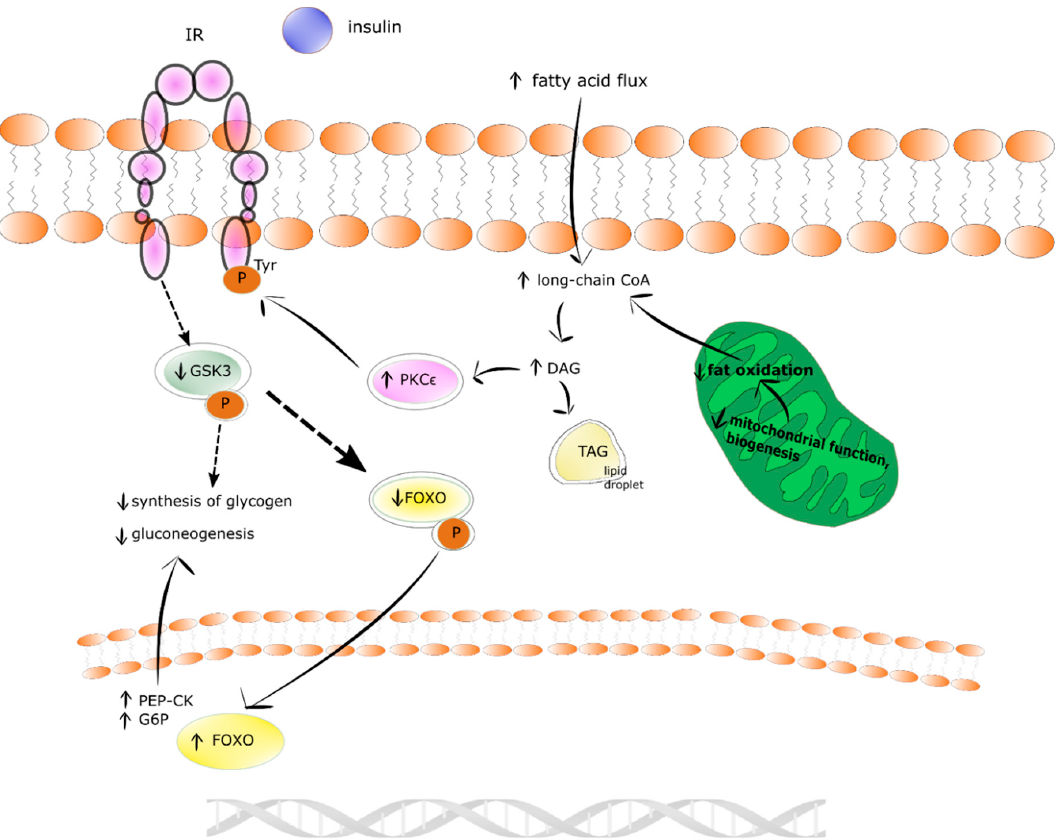
Figure 3. The insulin resistance mechanism in human liver. Physiological state is denoted by solid arrows and insulin resistant state by dotted arrows. ↓ denotes decrease ↑ denotes increase.